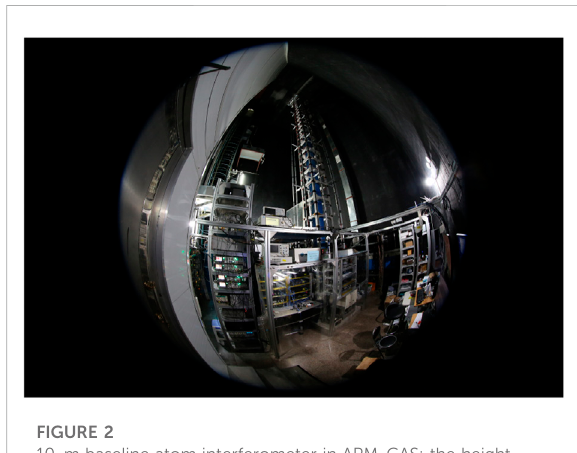
FIGURE 2 10-m baseline atom interferometer in APM-CAS: the height of the vacuum tube and magnetic shield are 12 and 11.4 m, respectively. APM-CAS represents the new name of the institute, that is, the Innovation Academy for Precision Measurement Science and Technology, Chinese Academy of Sciences